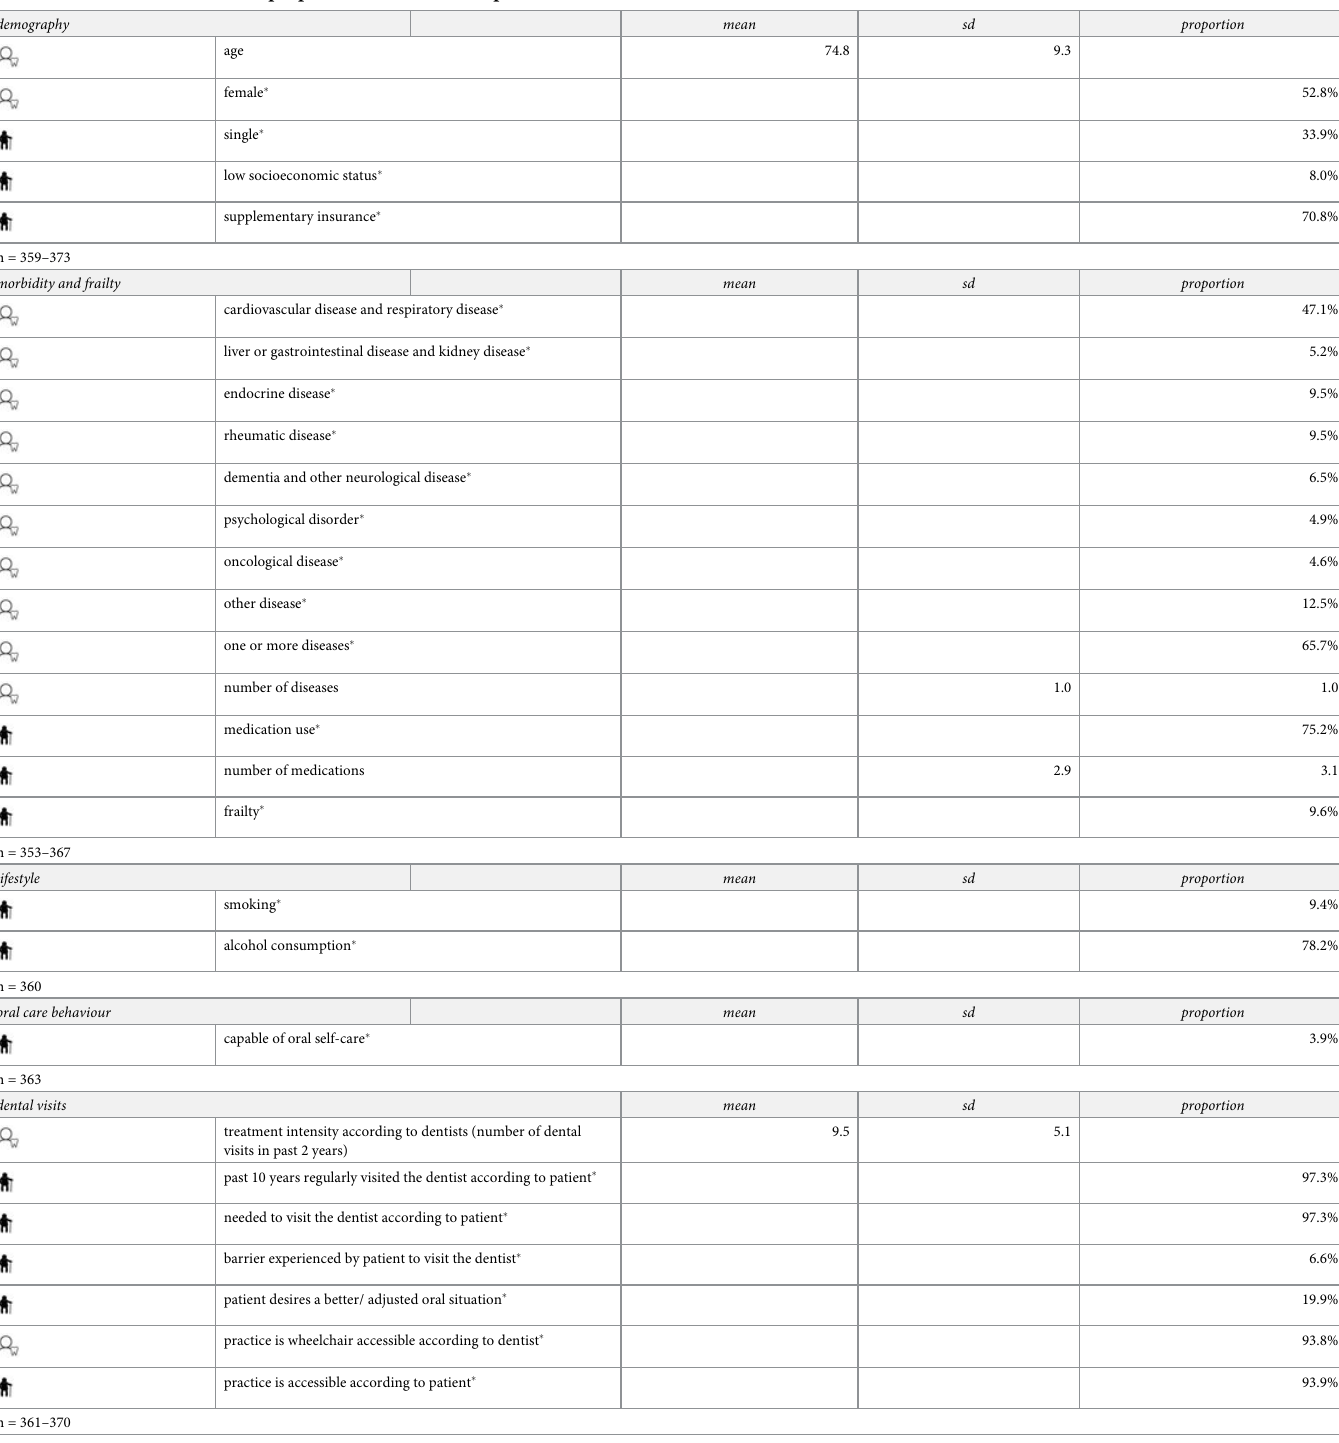
Table 1. Characteristics of older people who visit the dental practice.